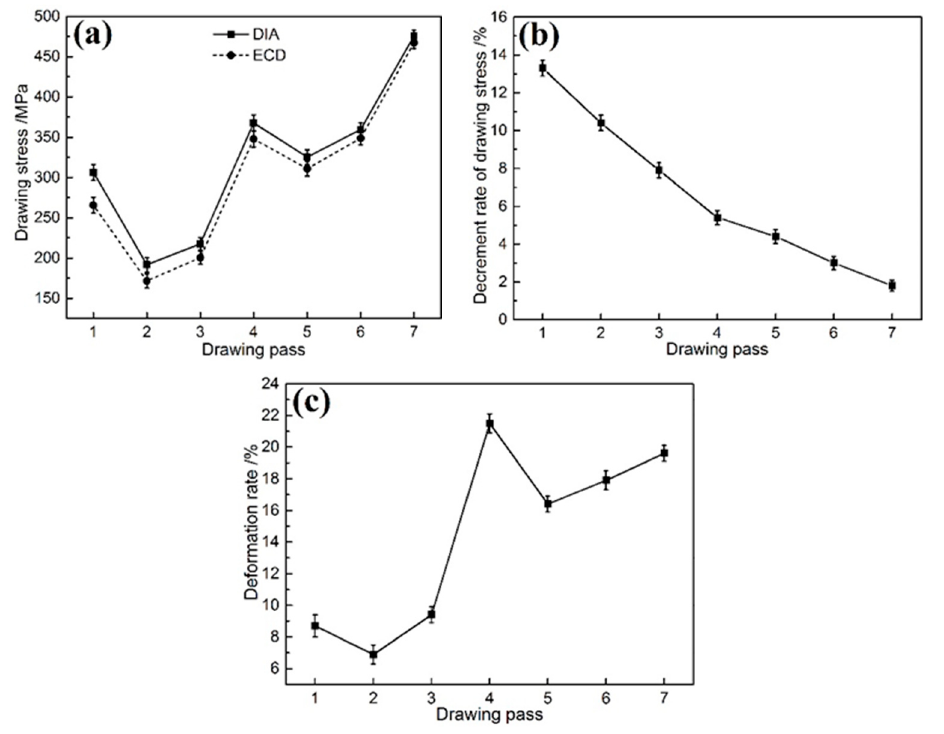
Figure 2. Variations of ( a ) drawing stress of electrochemical cold drawing (ECD) and cold drawing in air (DIA), ( b ) decrement rate of drawing stress of ECD compared with DIA, and ( c ) deformation rate with drawing pass.